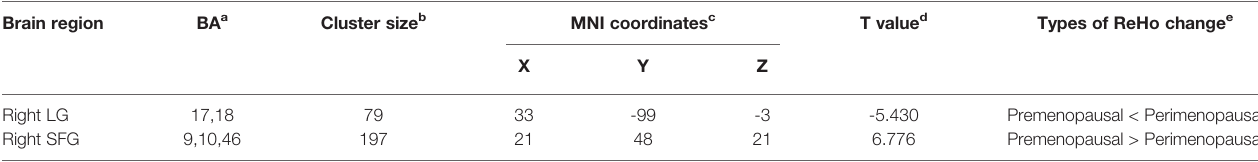
TABLE 2 | Brain regions with signi fi cant differences in ReHo values between premenopausal (n = 32) and perimenopausal women (n = 25) (Gaussian random fi eld corrected at voxel level p < 0.001, cluster level p < 0.05, two-tailed). Brain region BA a